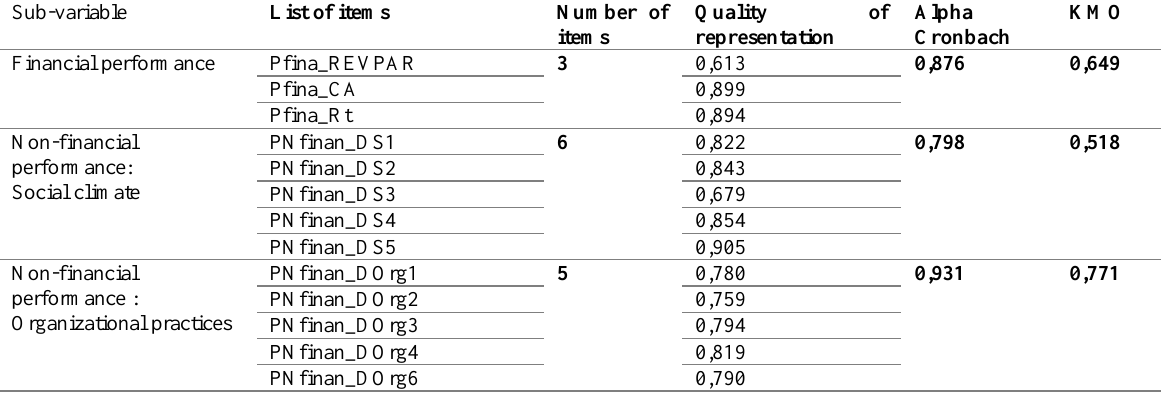
Table 5: Results of the purification of the measurement scale of the sub-variables of the “Firm Performance” variable